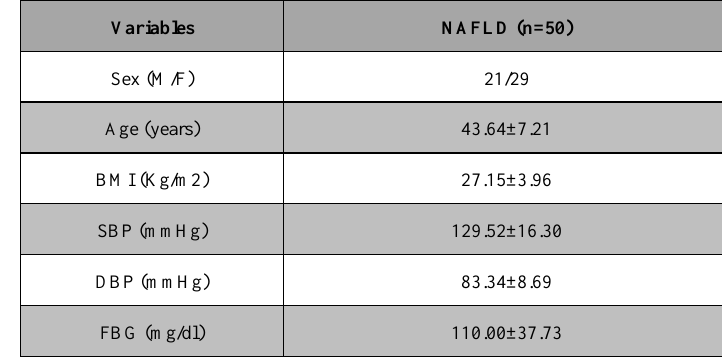
Table 1. Baseline characteristics of studied